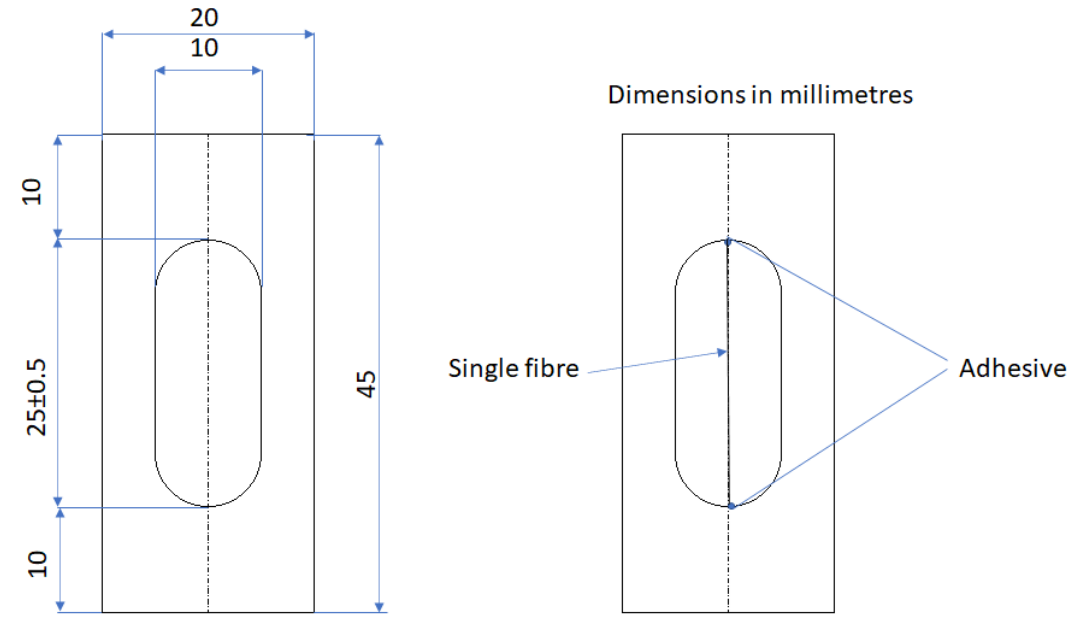
Figure A1. Tensile test setup for melt-spun MP/PE fibre.